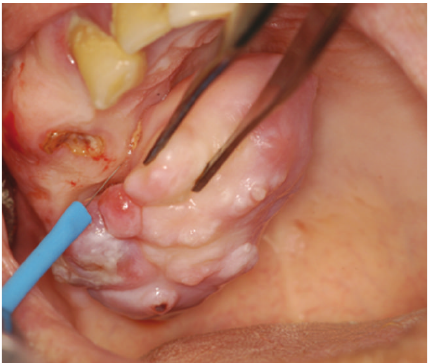
Figure 2: Removal of the lesion through the use of quantic molecular resonance (QRM) scalpel.